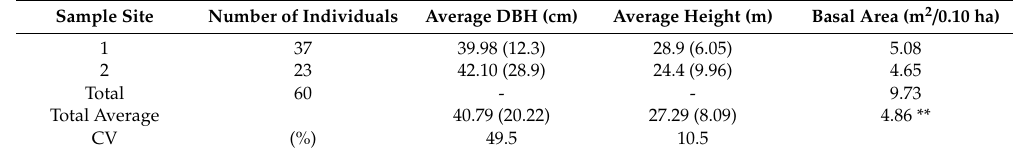
Table 4. Forest biometric variables of the tree structure in the Tlachanon